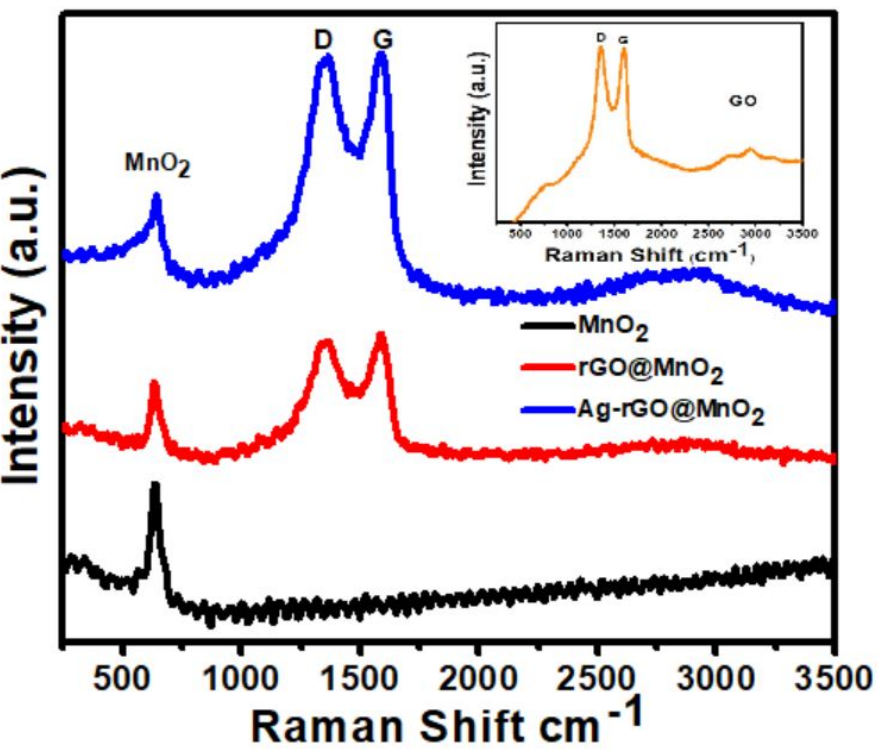
Figure 7. Raman spectrum of pure MnO 2 rods, rGO@MnO 2, and Ag-rGO@MnO 2 .